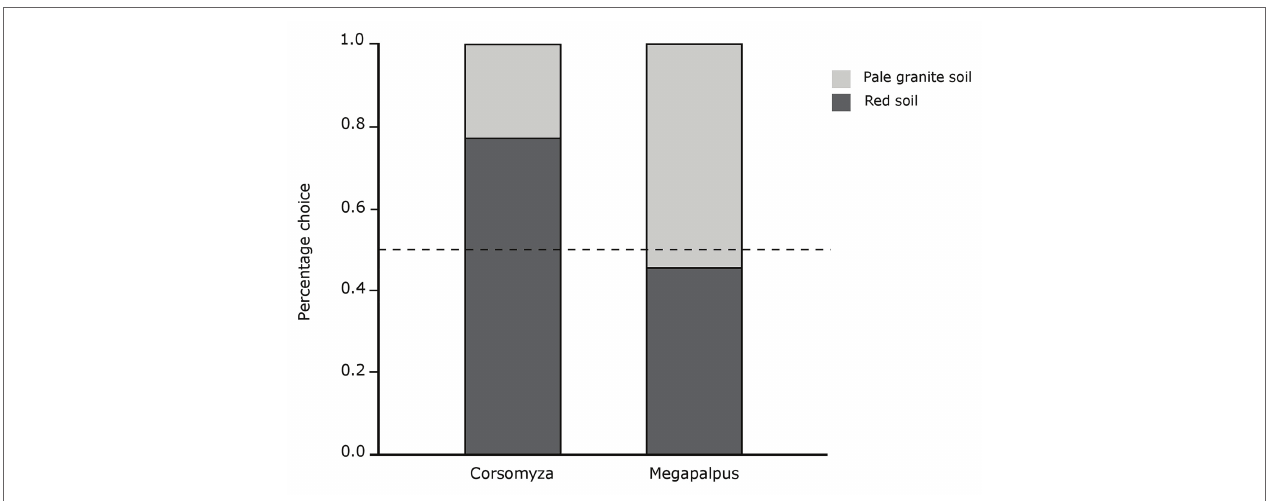
FIGURE 6 | Detectability of flower color on different background soils as quantified by initial choices of fly pollinators for flowers presented on different soil backgrounds. Corsomyza nigripes (usually found in white floral communities on red soils) chose white flowers ( Dimorphotheca pluvialis ) on a red soil background significantly more frequently that on pale soil, while Megapalpus capensis (usually found in orange floral communities on pale soils) visited orange flowers ( Dimorphotheca sinuata ) on both backgrounds with equal frequency. The dashed line indicates the expected choice ratio if there is no difference in detectability across